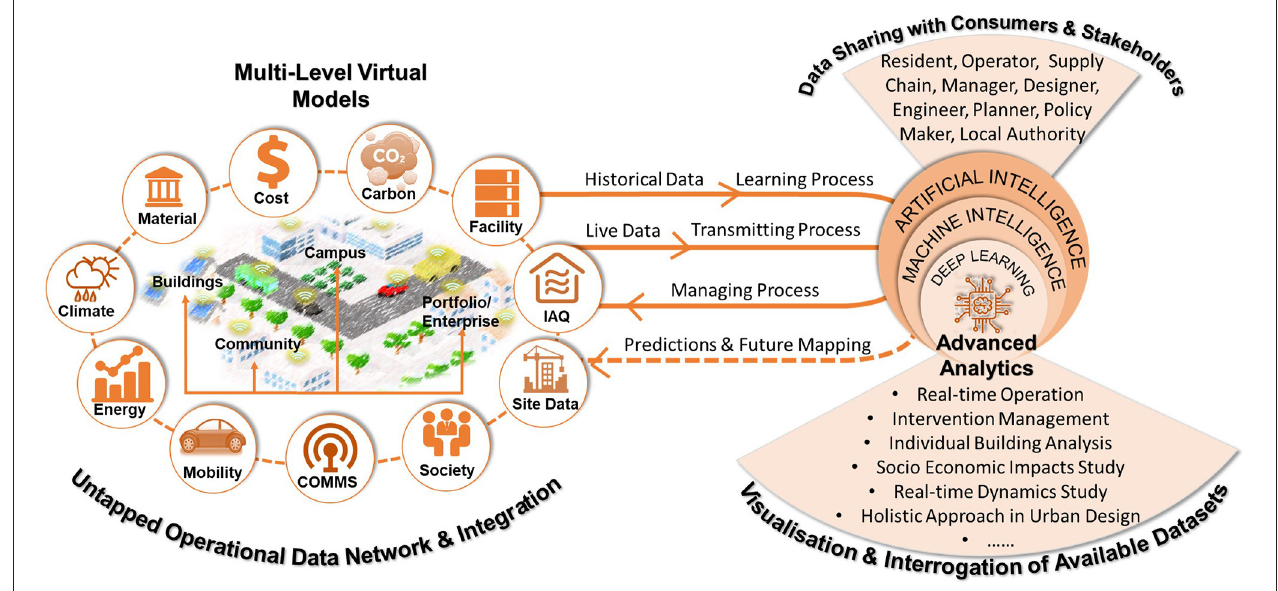
FIGURE 1 | Schematic design of key components in a digital PED